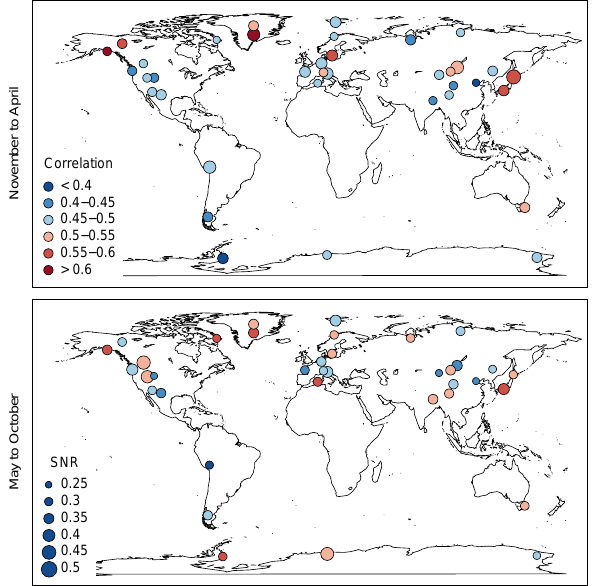
Fig. 2. Correlation and signal-to-noise ratio of pseudo-proxies with Fig.2. Correlationandsignal-to-noiseratioofpseudo-proxieswith reference time series in boreal winter (November to April, upper reference time series in boreal winter (November to April, upper panel)andsummer(MaytoOctober,lowerpanel). Thecolourin bothpanelsreflectsthecorrelationaccordingtothelegendinthe upperpanel,thesizeofthecirclesinbothpanelsreflectsthesignal- panel) and summer (May to October, lower panel). The colour in to-noiseratioaccordingtothelegendinthelowerpanel. both panels reflects the correlation according to the legend in the upper panel; the size of the circles in both panels reflects the signal- to-noise ratio according to the legend in the lower